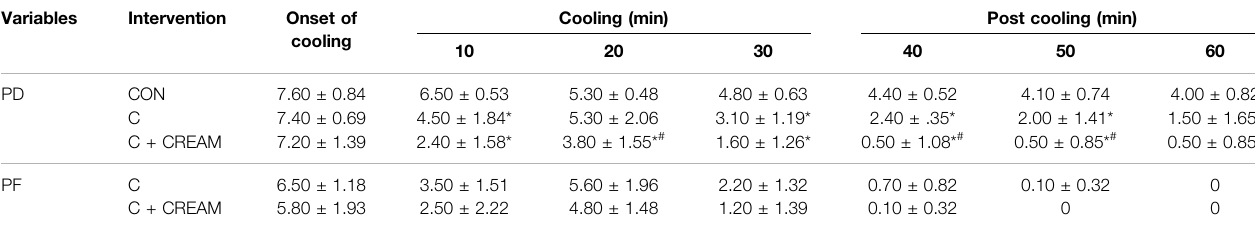
TABLE 3 | Perception of discomfort (PD) and perception of frostiness (PF) during cooling and post cooling in study 2. Variables